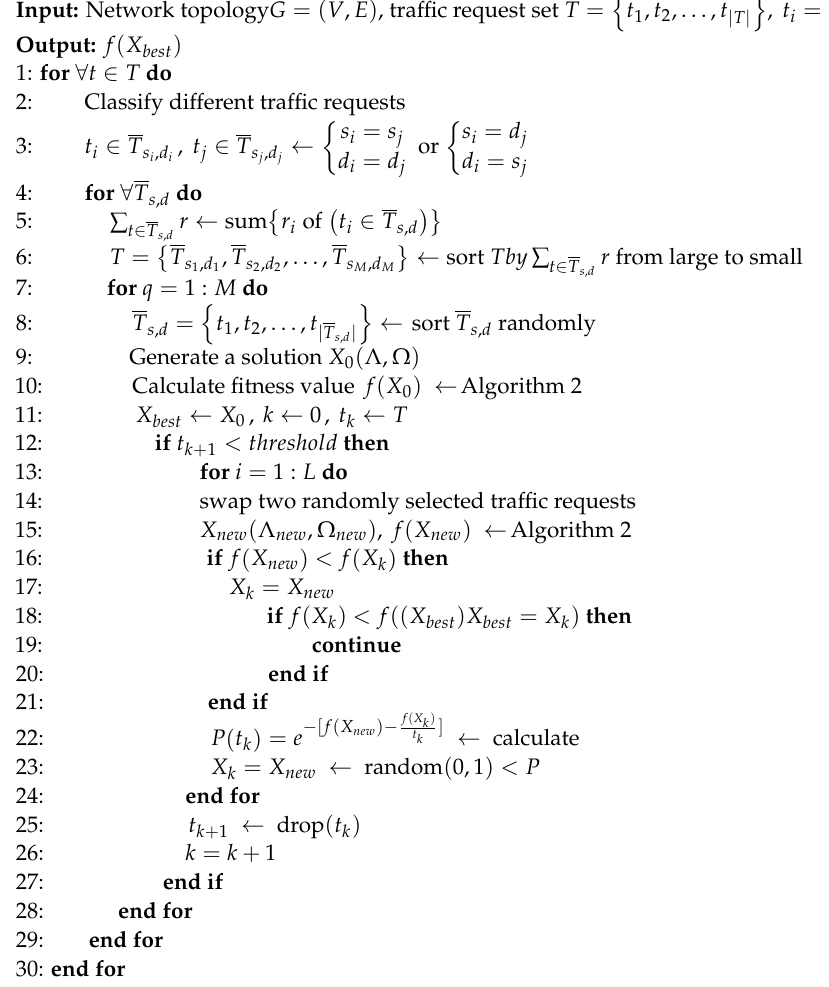
Algorithm 1 Traffic Request Order Optimization with